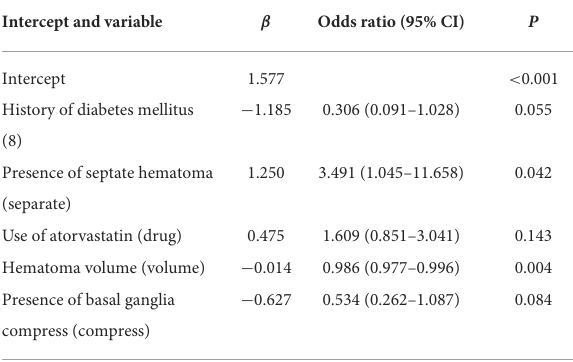
TABLE 2 Risk factors for good self-absorption in patients with CSDH by multivariable logistic